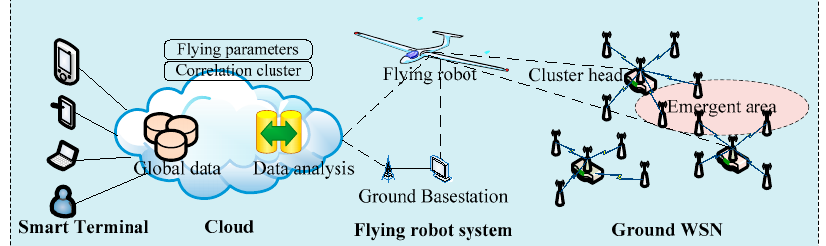
Figure 1. Topology of a hierarchical Unmanned Aerial Vehicles-Wireless Sensor Networks (UAV-WSN).